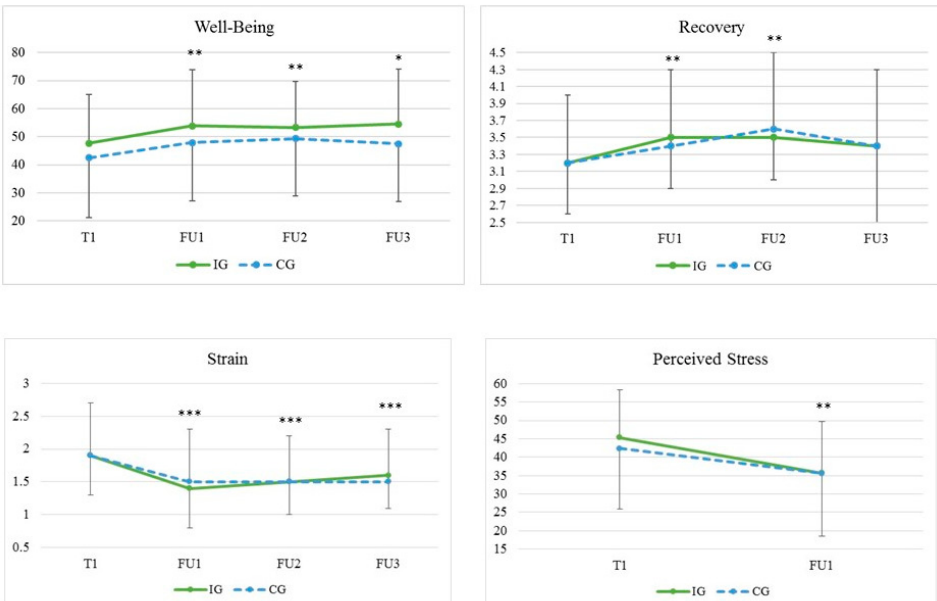
Figure 2. Sustainability of the effects of a short-term vacation on well-being, recovery, strain, and perceived stress. T1: Beginning of vacation, FU1: 15 days post-vacation, FU2: 30 days post-vacation, FU3: 45 days post-vacation. Control: Four nights at home; Intervention: Four nights in a 4* hotel. *** p < 0.001, Bonferroni-corrected, compared to T1. ** p < 0.01, Bonferroni-corrected, compared to